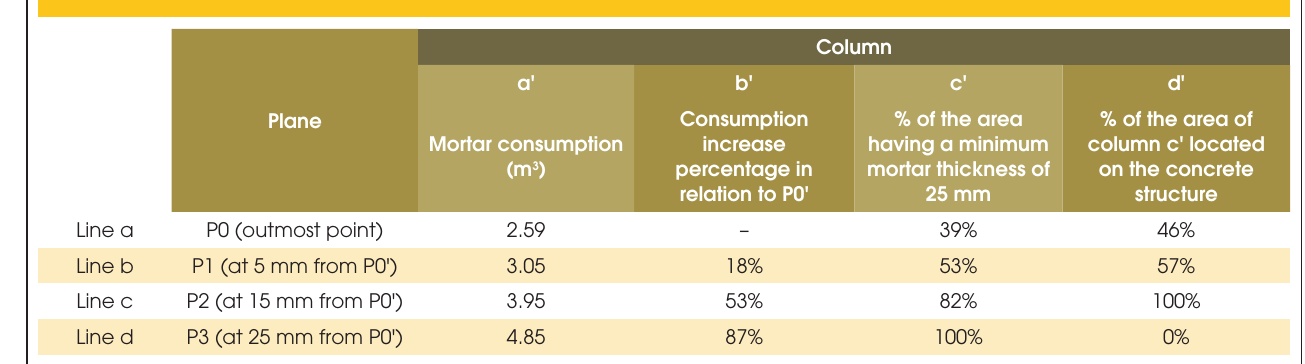
Table 4 – Results obtained from the 2 nd reference plane